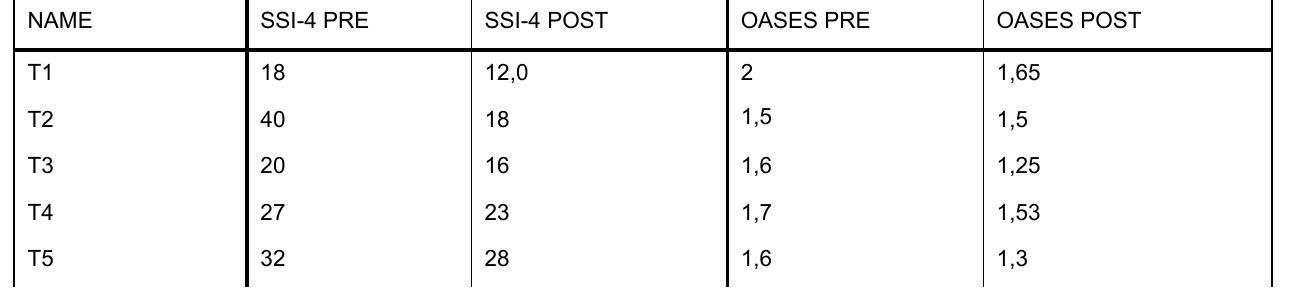
SSI-4 and OASES's total scores pre and post treatment Telepractice Group